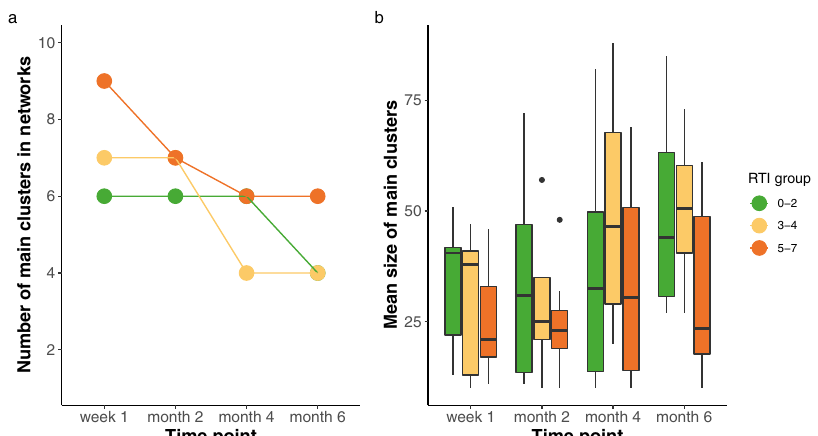
Fig. 2 Cluster number and size of the cross-niche microbial networks built per RTI group. Number of main clusters ( a ) and mean size of main clusters ( b ) over time. Number of clusters at week 1 were n = 22 ( n = 6 for 0 – 2 RTIs, n = 7 for 3 – 4 RTIs and n = 9 for 5 – 7 RTIs), n = 20 at month 2 ( n = 6 for 0 – 2 RTIs, n = 7 for 3 – 4 RTIs and n = 7 for 5 – 7 RTIs), n = 16 at month 4 ( n = 6 for 0 – 2 RTIs, n = 4 for 3 – 4 RTIs and n = 6 for 5 – 7 RTIs) and n = 14 at month 6 ( n = 4 for 0 – 2 RTIs, n = 4 for 3 – 4 RTIs and n = 6 for 5 – 7 RTIs). Boxplots with medians are shown; the lower and upper hinges correspond to the fi rst and third quartiles (the 25th and 75th percentiles); the upper and lower whiskers extend from the hinge to the largest and smallest value no further than 1.5 *IQR from the hinge. RTI stands for number of respiratory tract infections experienced over the fi rst year of life.